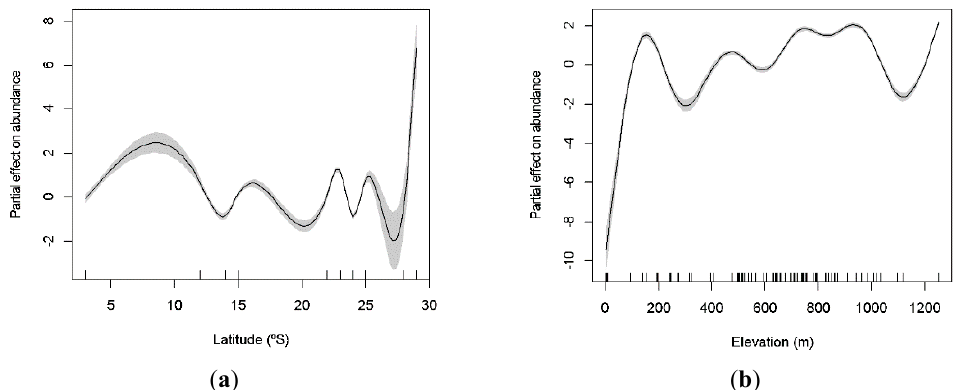
Figure 4. GAM-derived effect of latitude ( a ) and elevation ( b ) on species abundance of cave-dwelling bats. The value of 0 on the y-axis is the mean of abundance. The approximate 95% confidence envelopes are indicated (grey shading). Tick marks on the x-axis are sampled data points.